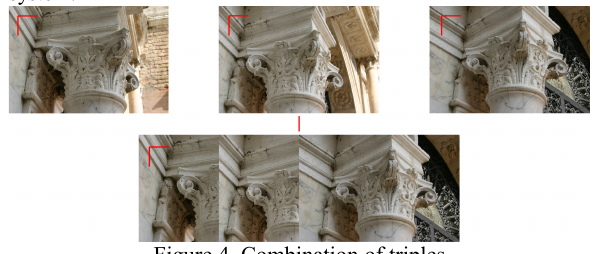
Figure 4. Combination of triples